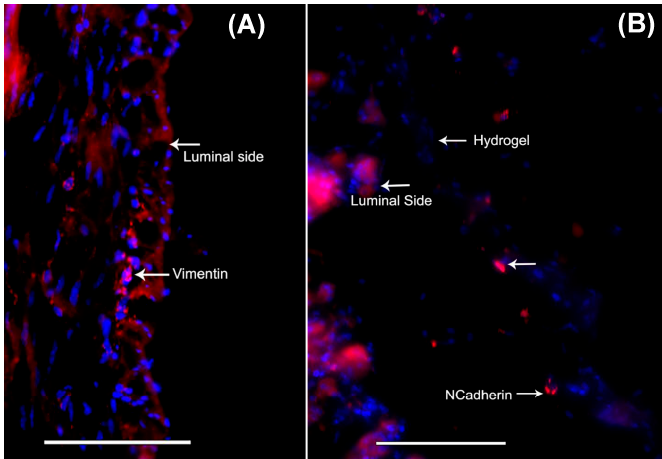
Figure 5. When the mouse-MSC-seeded gels were placed atop the stomach lumen, the cells migrated from the gels to the luminal tissues, as shown by positively stained cells for the stem cell markers, ( A ) vimentin and ( B ) N -cadherin. Scale bar in both images denotes 100 μ m. ( A ) vimentin and ( B ) N -cadherin. Scale bar in both images denotes 100 µ